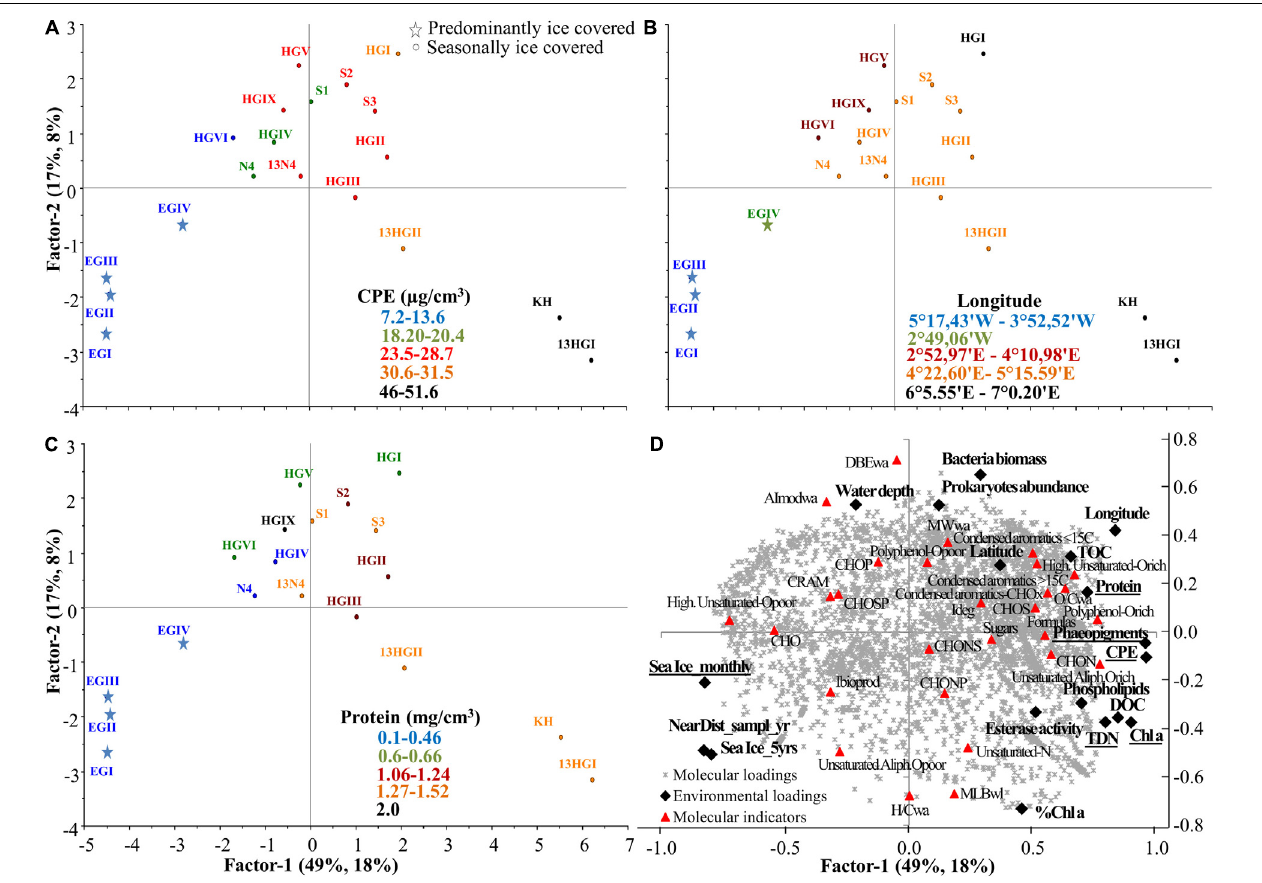
FIGURE 6 | Partial Least Square (PLS) analysis of surface porewater (0–1 cm) samples with factor 1 explaining 49 and 18% of the environmental and molecular variability, respectively, and factor 2 explaining 17 and 8%. (A) Scores plot (samples indicated by the name of the station, Supplementary Table S1 ) color coded with CPE, (B) longitude and (C) protein content, and (D) correlation of environmental (X loadings) and molecular loadings (Y loadings), passively displaying the evaluated molecular categories, ratios and indices (see molecular indicators in Supplementary Figure S1 and Supplementary Table S2 ). Underlined environmental variables are significantly influencing surface porewater DOM composition. Sea ice variables: Sea Ice_montly, Sea Ice_5yrs and NearDist_sampl_yr, stand for sea ice monthly average, 5 years average and nearest distance to the ice margin ( Supplementary Table S1